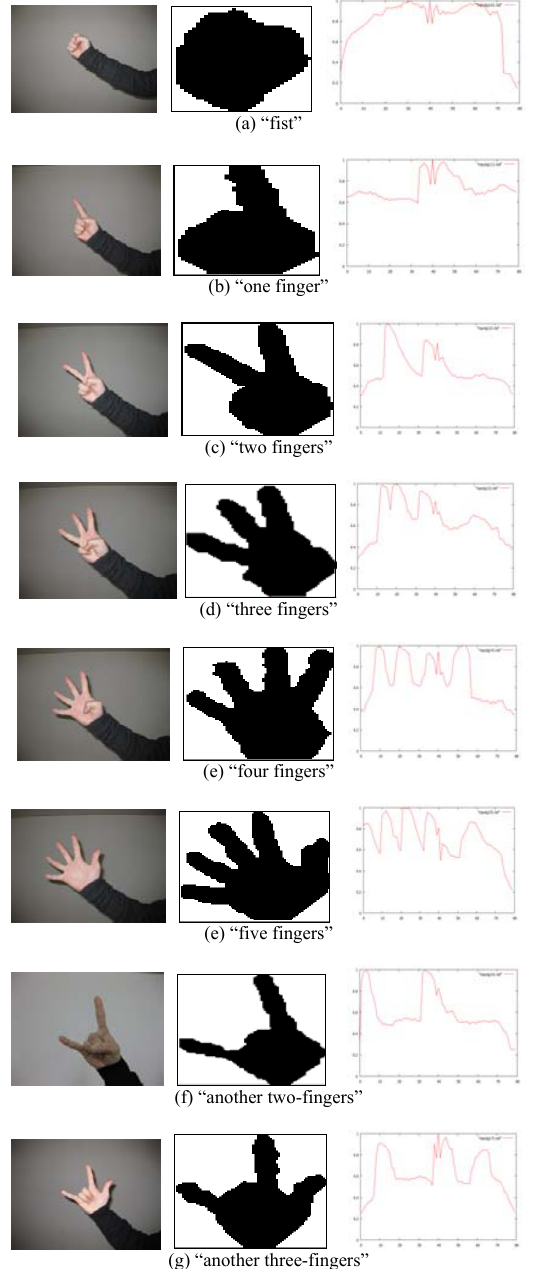
Fig. 7. Hand shapes for instruction learning of robot. Left: original image; Center: binary image; Right: normalized feature (input of SOM).